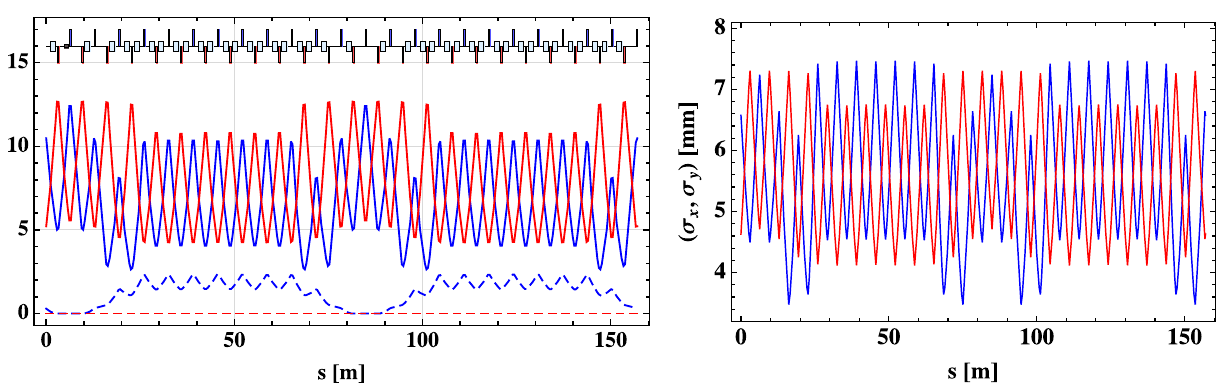
FIG. 20. Optics and one rms beam envelope of the 24-cell FODO lattice with 2 × 2 cells of straight section with only two quadrupole families (no ind. quad), with additional individual quadrupoles for beta-beating correction (ind. quad) and with a half missing bend dispersion suppression scheme (disp.). The beam envelope has been calculated using the design transverse normalized rms emittance of 2 . 5 μ m and the rms momentum spread corresponding to the design longitudinal emittance of 2.8